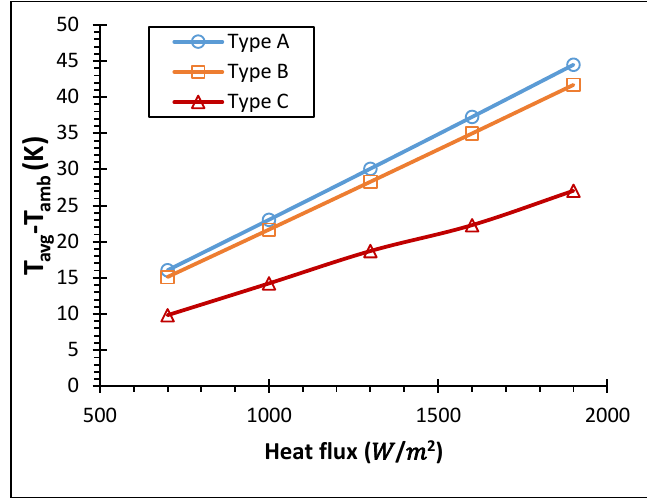
Figure 8: Comparison of temperature difference against heat flux at different model